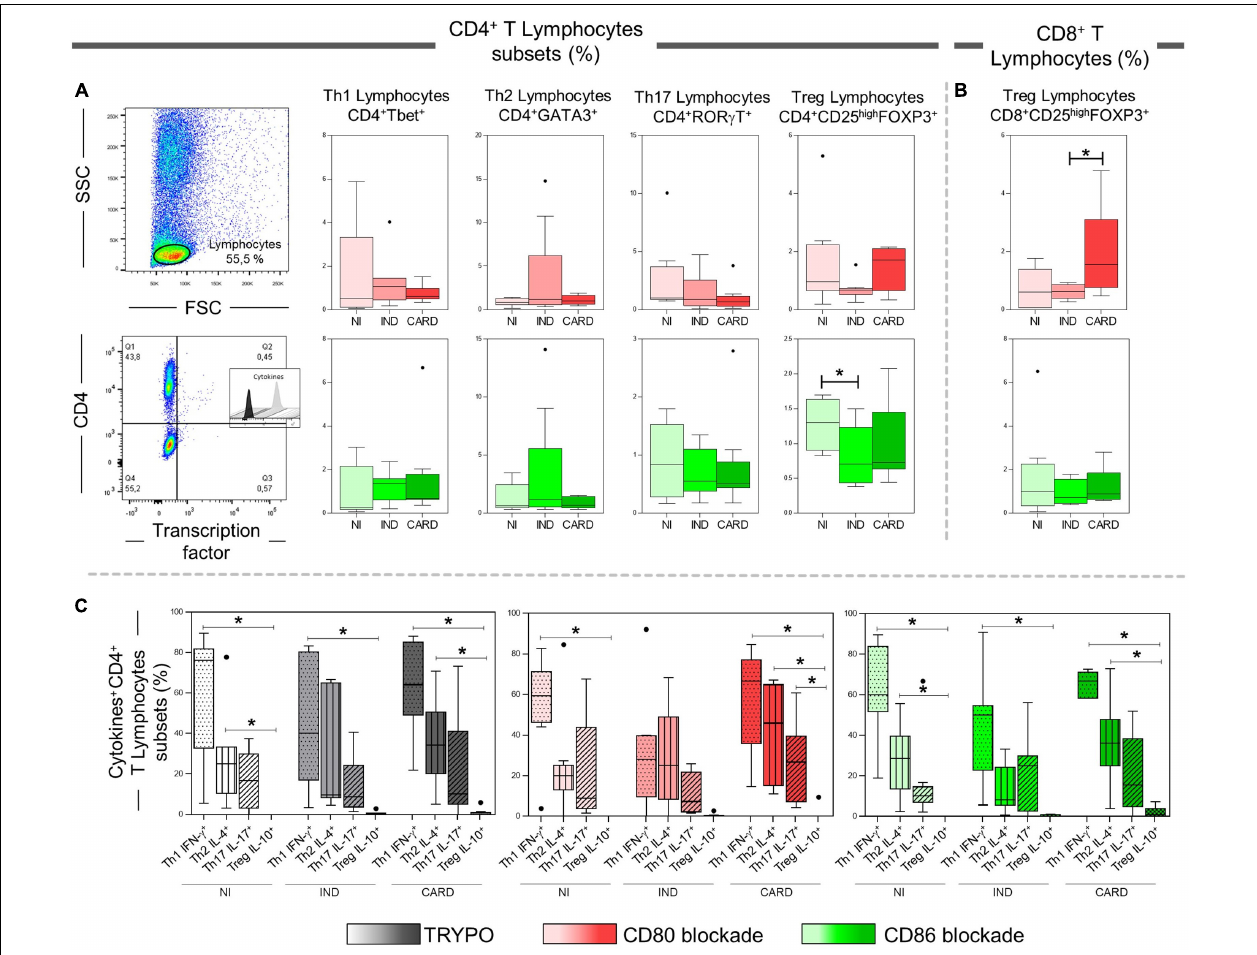
FIGURE 4 | Analysis of CD4 + and CD8 + T lymphocytes subsets after anti-CD80 and anti-CD86 antibody blockade and pattern of expressed cytokines in PBMC cultures with TRYPO, CD80, or CD86 antibody blockade. Flow cytometry gate strategy of non-infected (NI) individuals is represented. Frequency of Th1, Th2, Th17, and CD4 + Treg lymphocytes (A) and CD8 + Treg lymphocytes (B) after in vitro stimulation with T. cruzi antigens and anti-CD80 and anti-CD86 antibody blockade. Th1 IFN- γ + , Th2 IL-4 + , Th17 IL-17 + , and CD4 + Treg IL-10 + PBMC cultures with TRYPO, with anti-CD80 antibody blockade, and with anti-CD86 antibody blockade (C) from NI individuals ( n = 9), indeterminate (IND, n = 9), and cardiac (CARD, n = 11) clinical forms of Chagas disease. Statistical differences ( p < 0.05) between groups were obtained by Kruskal–Wallis test, followed by Dunn’s post-test, and represented by asterisk (*) and lines. Boxes demonstrate the median and interquartile ranges, whiskers evidence the highest and lowest observation, and dots represent the